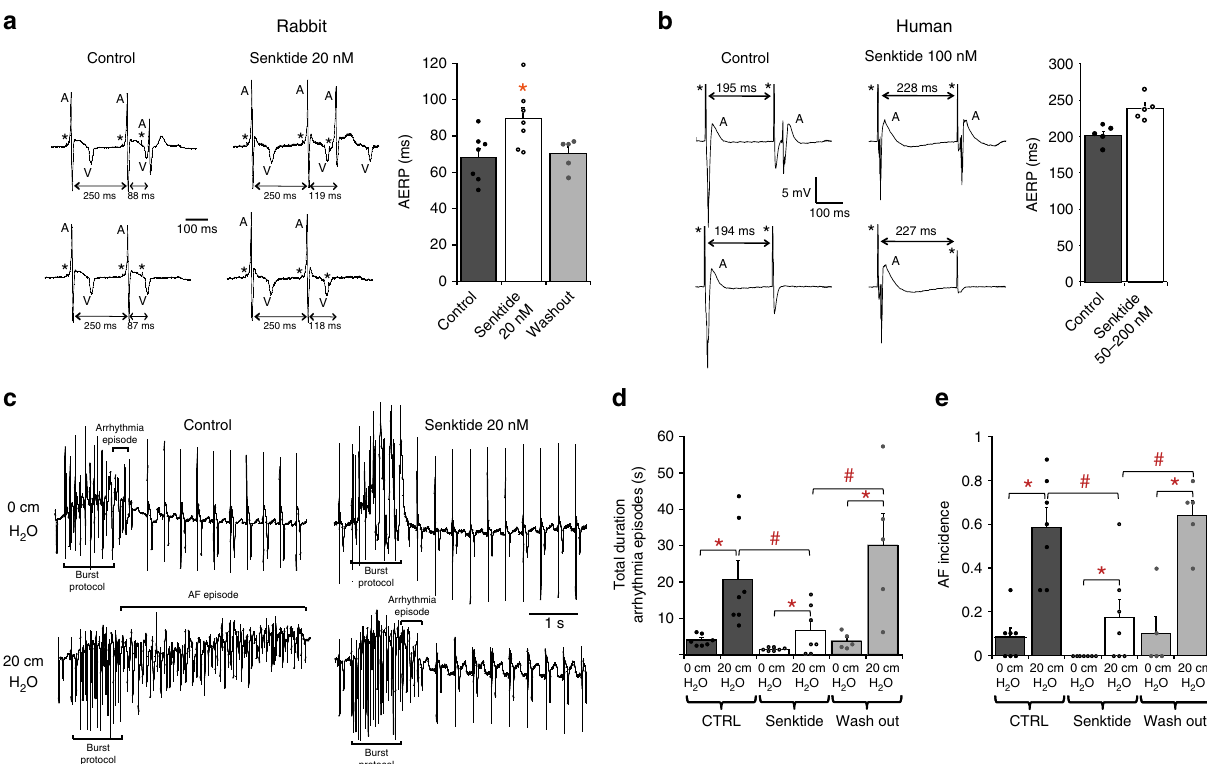
Fig. 8 Effect of NK-3R stimulation on ERP and AF inducibility in atria of human and rabbit. a Unipolar electrograms recorded from the left atrium of a Langendorff-perfused rabbit heart before (Control) and after application of 20 nM of Senktide (left). Bar graph showing average values for AERP in Control, in the presence of 20 nM Senktide, and after wash-out (right, N = 7, one-way RM ANOVA). b Unipolar electrograms recorded from human LAA before (Control) and after application of 100 nM of Senktide (left). Bar graph showing average values for AERP in Control and in the presence of 50 – 200 nmol/L Senktide (right, N = 5, paired t -test, p = 0.06). c Unipolar electrograms recorded from the left atrium of a rabbit Langendorff-perfused heart following a burst pacing protocol in the absence (Control, left) and in the presence of 20 nM of the NK-3R agonist Senktide (right), at baseline (0 cm H 2 O, upper tracings) and during atrial dilatation (20 cm H 2 O, lower tracings). d , e Bar graph showing average values for total duration of arrhythmia episodes d and AF incidence e in Control, after application of 20 nM Senktide, and after wash-out ( N = 7, two-way RM ANOVA). All values shown are mean ± SEM. * P < 0.05. Electrograms: A atrial activation; V ventricular activation; *